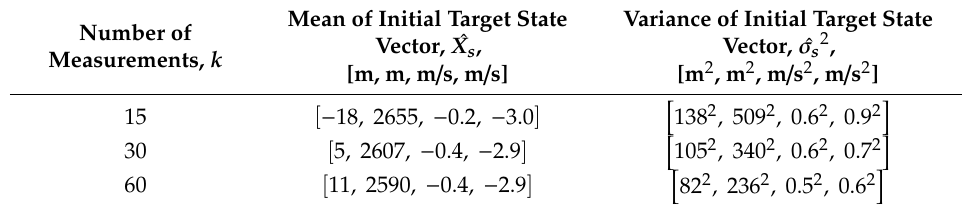
Table 3. The means and variances of the estimated initial state vector [ˆ p xm ( 1 ) , ˆ p ym ( 1 ) , ˆ v xm ( 1 ) , ˆ v ym ( 1 ) ] for three di ff erent measurement